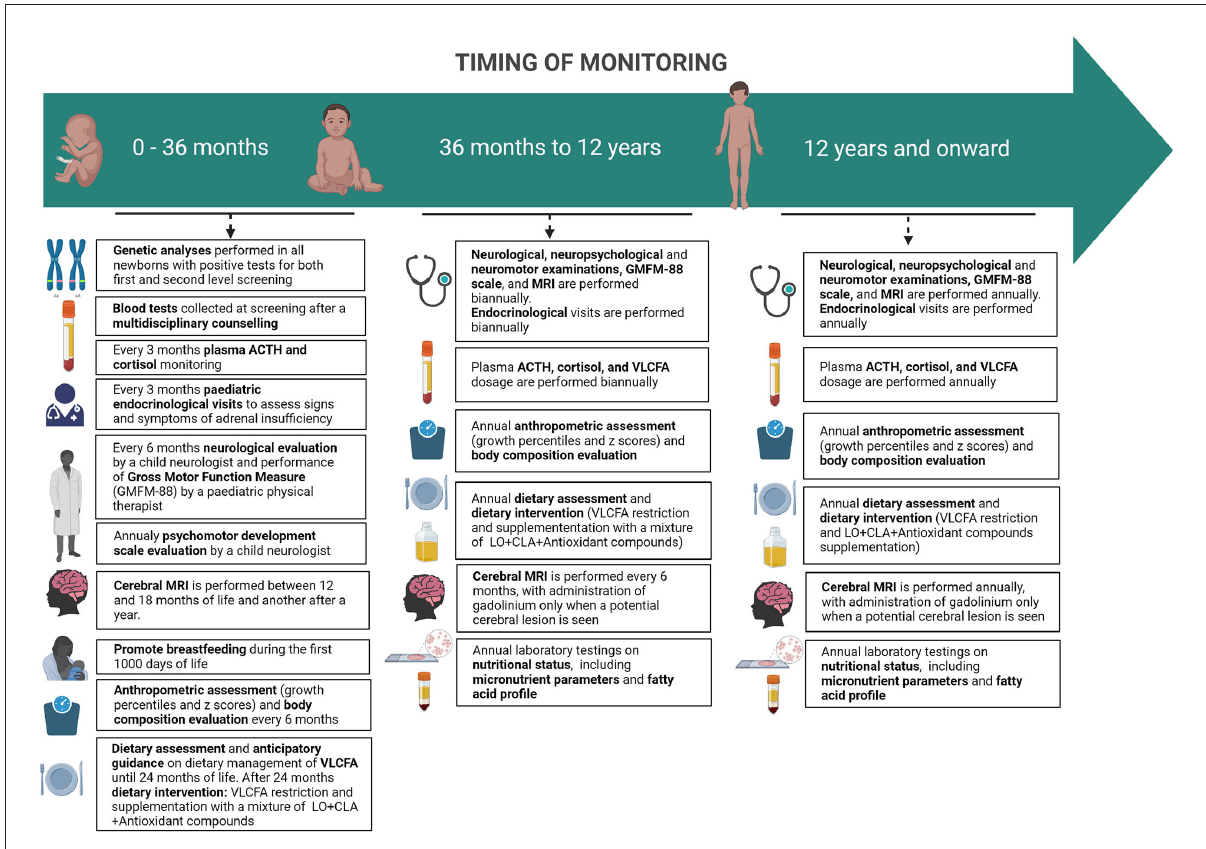
FIGURE2 Timing of monitoring of pre-symptomatic ABCD1-mutated males